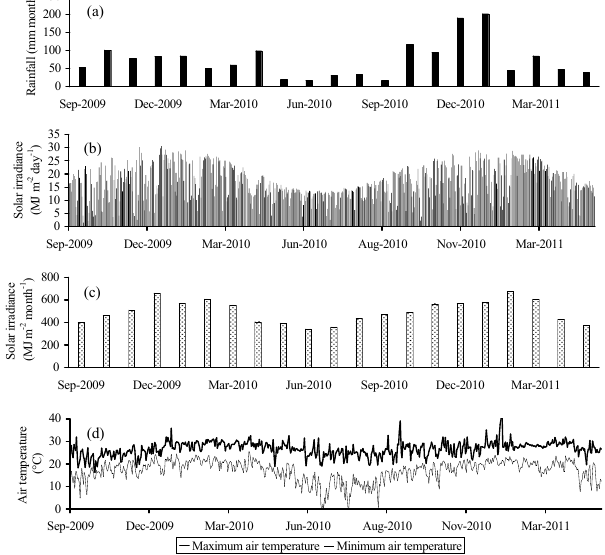
Fig. 3. The (a) monthly rainfall, (b) daily solar radiant density, (c) monthly solar radiant density, and (d) daily maximum and min- imum air temperatures at the Mfabeni